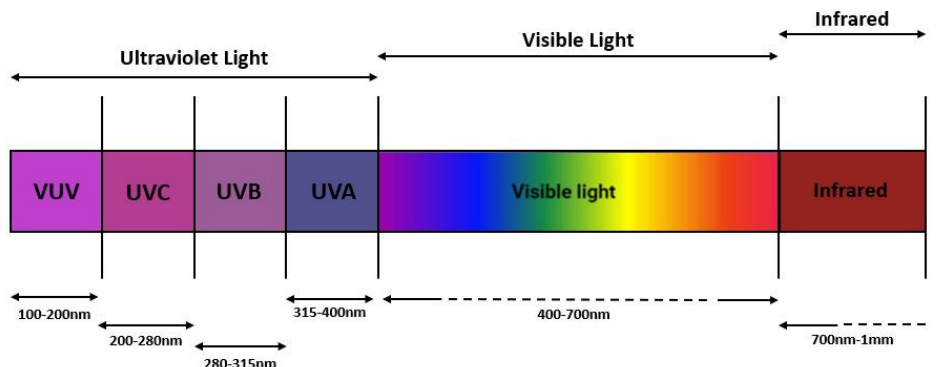
Figure 1. Electromagnetic spectrum where different types of electromagnetic radiation are depicted: V-UV (100–200 nm); UV-C (200–280 nm); UV-B (280–315 nm); UV-A (315–400 nm); visible spectrum (400–700 nm); infrared spectrum (700 nm–1 mm). UV-A represents the most abundant portion of ultraviolet rays that reach the earth’s surface, in fact only 5% is absorbed by the ozone layer. On the other hand, UV-B and UV- C are absorbed, correspondingly, for 95% and 100% in the upper part of the stratosphere. UV-A is mainly used in light therapy and 3D printing, but it is harmful to human health. Indeed, it can reach the dermis and cause lipid peroxidation, oxidative stress, and cellular apoptosis through the generation of reactive oxygen species (ROS) leading to premature aging and damage of many cellular components such as proteins or lipids [14,15]. Unlike UV-A, that exerts its harmful effects on cellular components through the generation of oxidative stress, UV-B, and even more UV-C rays, damage skin cells mostly by their direct radiant effect on DNA. V-UV has an even stronger ionizing power than UVC light and can generate high concentration reactive species such as ozone and OH radicals [16] but a wavelength in the range of 100–200 nm is absorbed by the air thus not being able to travel far in the air. Regarding the production of ozone, it must be emphasized that, as stated by the Scientific Committee on Health, Environmental and Emerging Risks (SCHEER), UV- C can generate ozone if wavelengths below 240 nm are used [17]. The wavelength range of UV-B (only under 300 nm) and UV-C coincides with the absorption spectra of DNA, RNA, and proteins. In particular, they can damage DNA, causing strand breaks and pos- sibly leading to mutation and neoplastic transformation [18]. Despite harmful effects to human health, this capability can be important in air and surface sanitization through the elimination of many microorganisms, especially using UV-C rays. 1.1. UV-C Absorption and Cellular DNA Damage As is well-known from the literature, UV-C rays have an intense germicidal activity. As shown in Figure 2, this effect is made possible thanks to the enormous cell damage, the predominant nature of which involves cyclobutane pyrimidine dimers (CPD), which UV- C rays, at an optimal wavelength around 265 nm [17,19], induce into microorganism DNA/RNA. The genetic damage from exposure to UV-C rays is carried out indifferently at the nucleic acids that make up the genome of eukaryotic cells, viruses and prokaryotic microorganisms. Generally, the dimerization caused by exposure to UV-C occurs between two consecutive thymine residues, causing the collapse of Hydrogen bonds between Thy- mine and Adenine, forming a new Thymine–Thymine dimer [20,21].